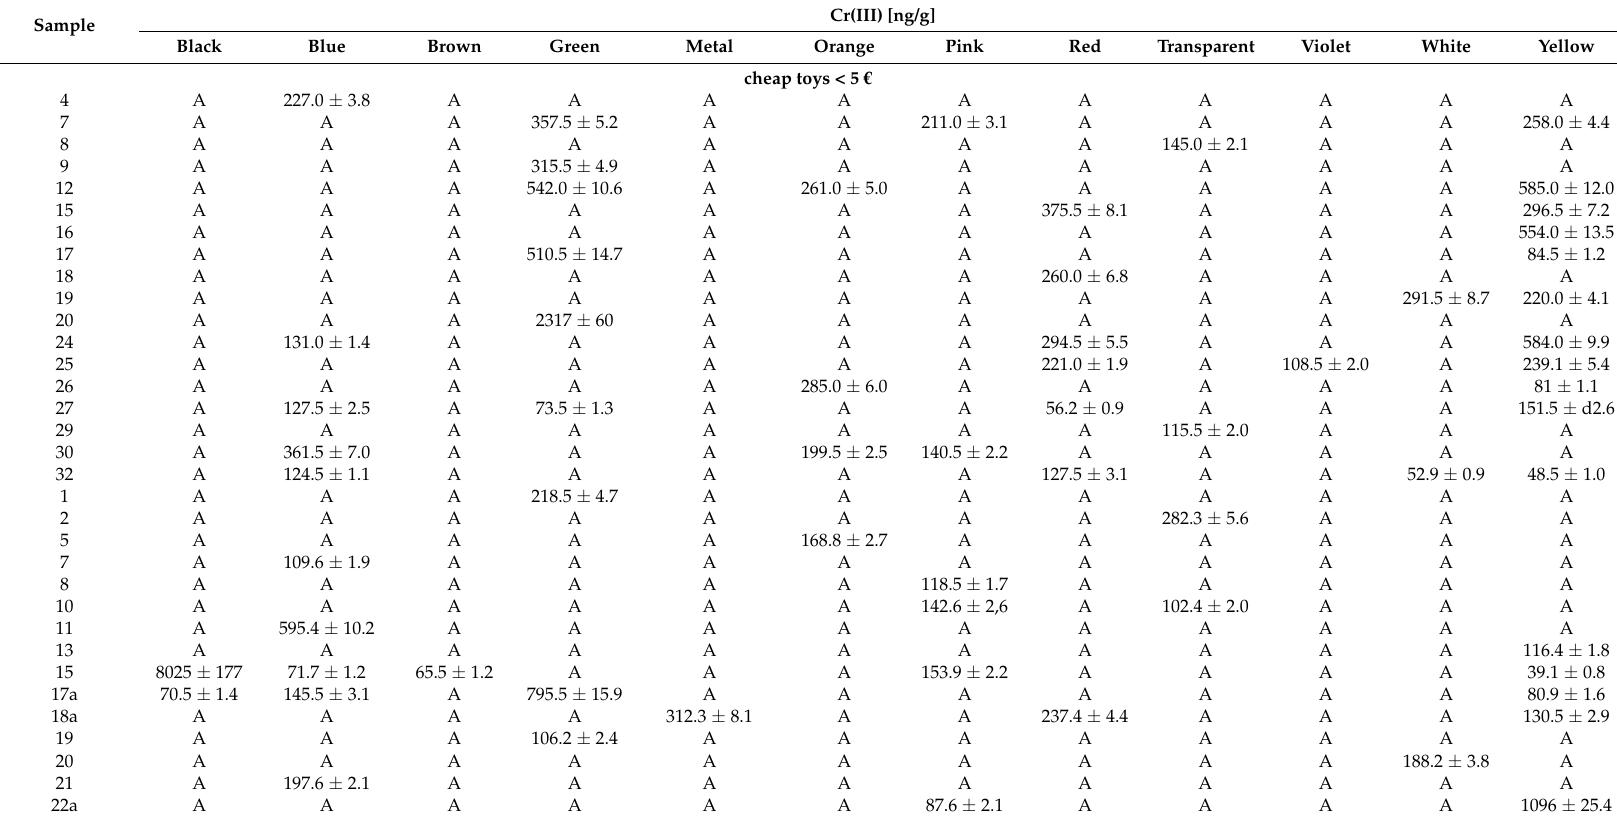
Table 1. Concentrations values of chromium(III) for particular